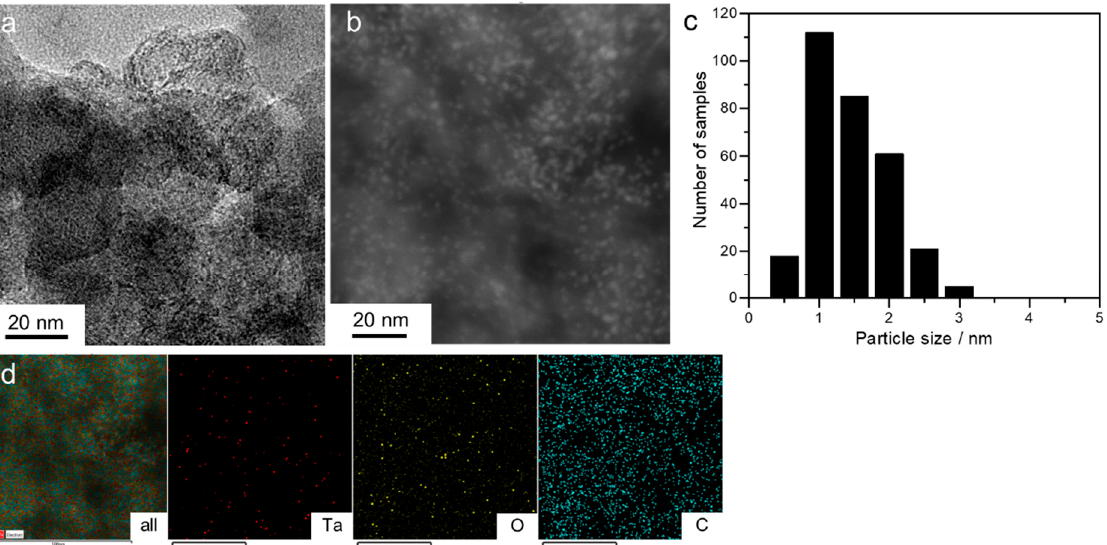
Figure 1. Surface morphology of ultrafine TaO x /CB nanoparticles ( a ) TEM and ( b ) STEM images of ultrafine TaO x /CB nanoparticles prepared by electrodeposition and subsequent annealing treatment in an H 2 flow. ( c ) Size distribution and ( d ) elemental EDS mapping results for the prepared fine particles shown in ( b ).